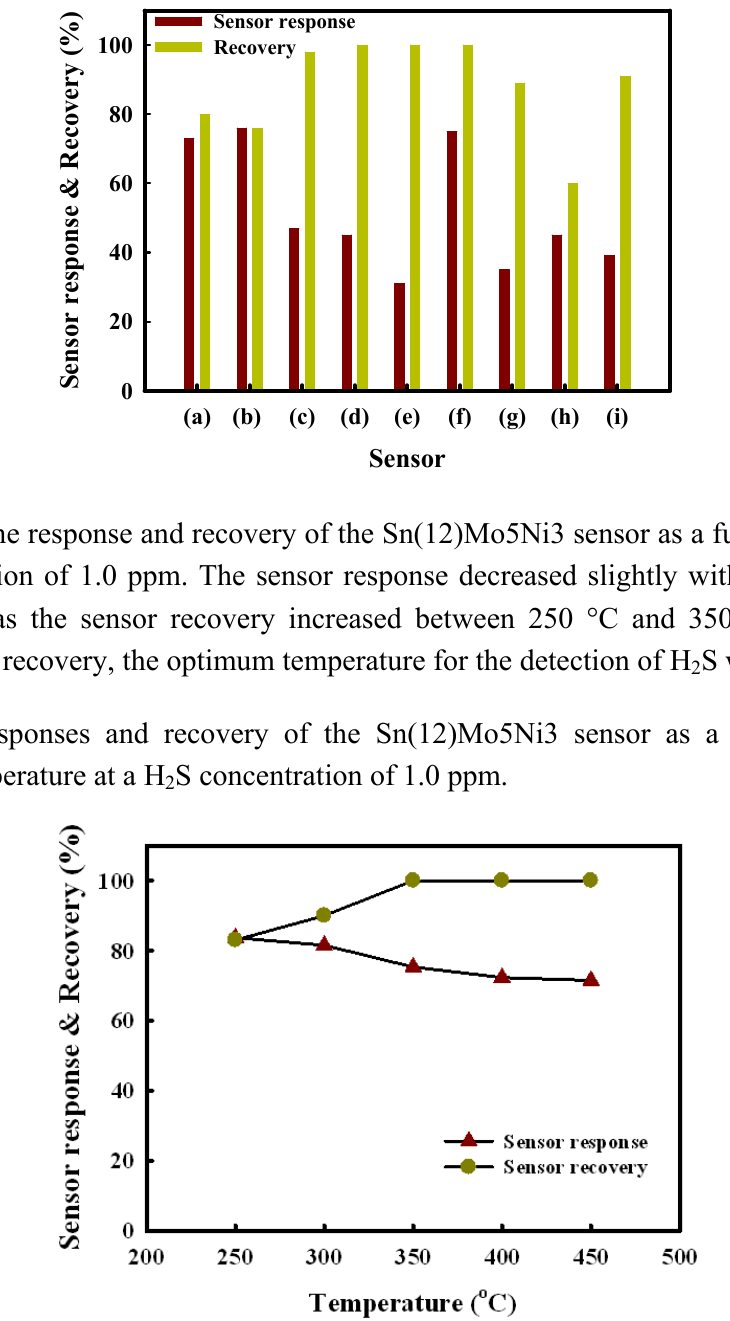
-based gas sensors promoted with various 2 S concentration of 1.0 ppm at 350 °C; (a) SnO 2